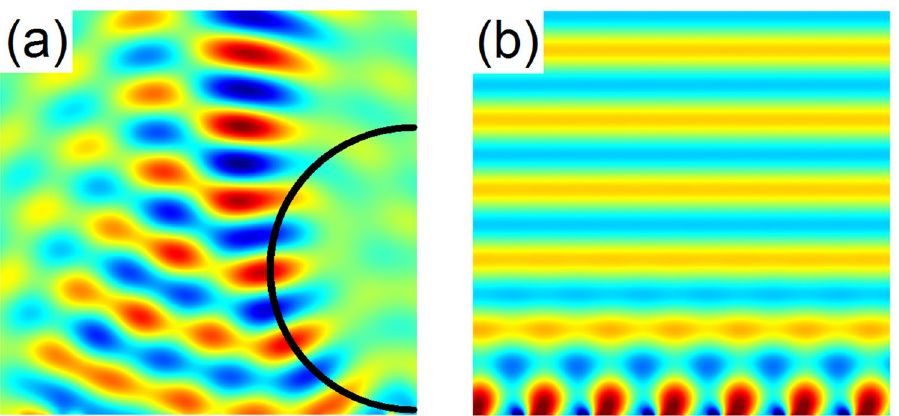
Figure 6. Reflected pressure field patterns in 400 Hz. ( a ) Acoustic wave bending along a half-circle trajectory and the design radius is 2 λ 0 . ( b ) Conversation of a propagating wave into a surface